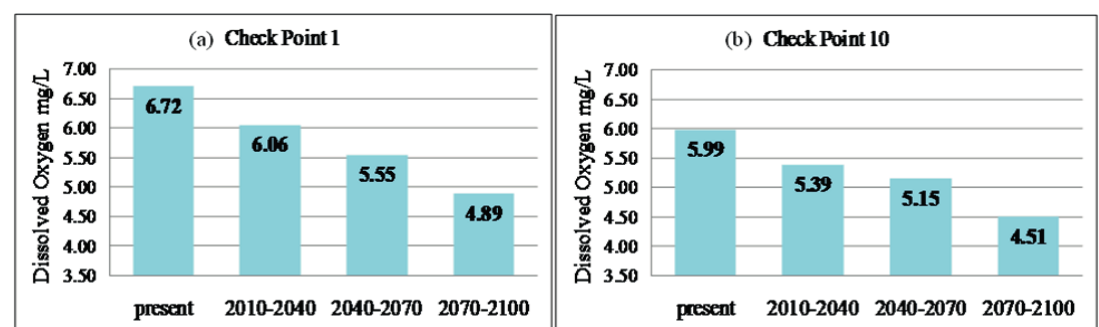
Fig. 2 Present and future DO-level estimates at two check points along the Tunga-Bhadra River (source: Rehana and Mujumdar